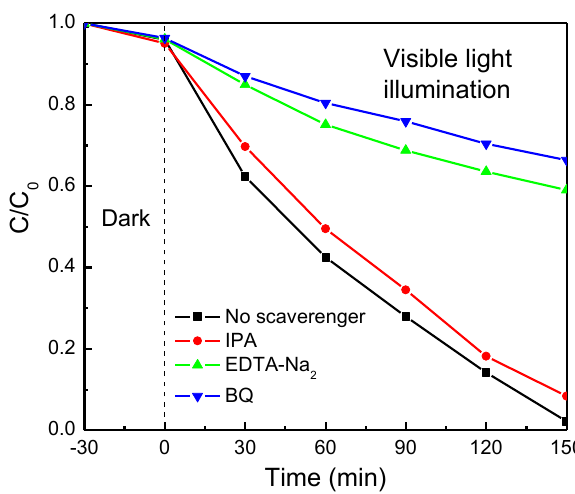
Figure 8. Photocatalytic RhB degradation curves of Bi 2 O 2 CO 3 /CdS QDs-10 containing with different scavengers.